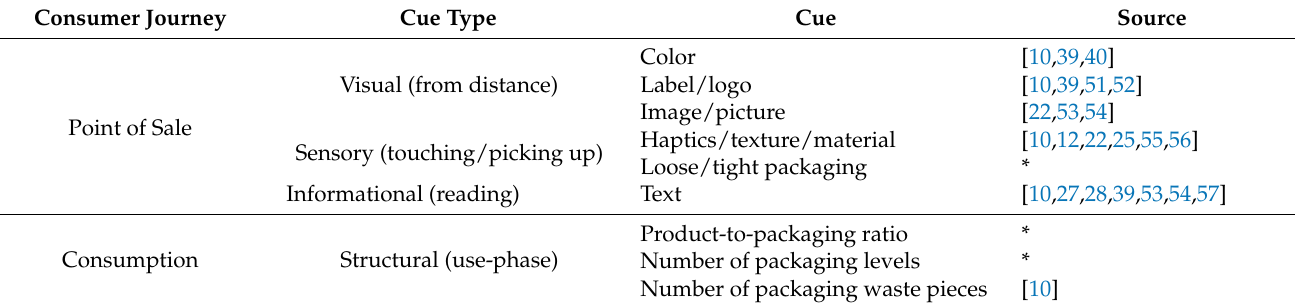
Table 2. Cues on pro-environmental attributes of packaging